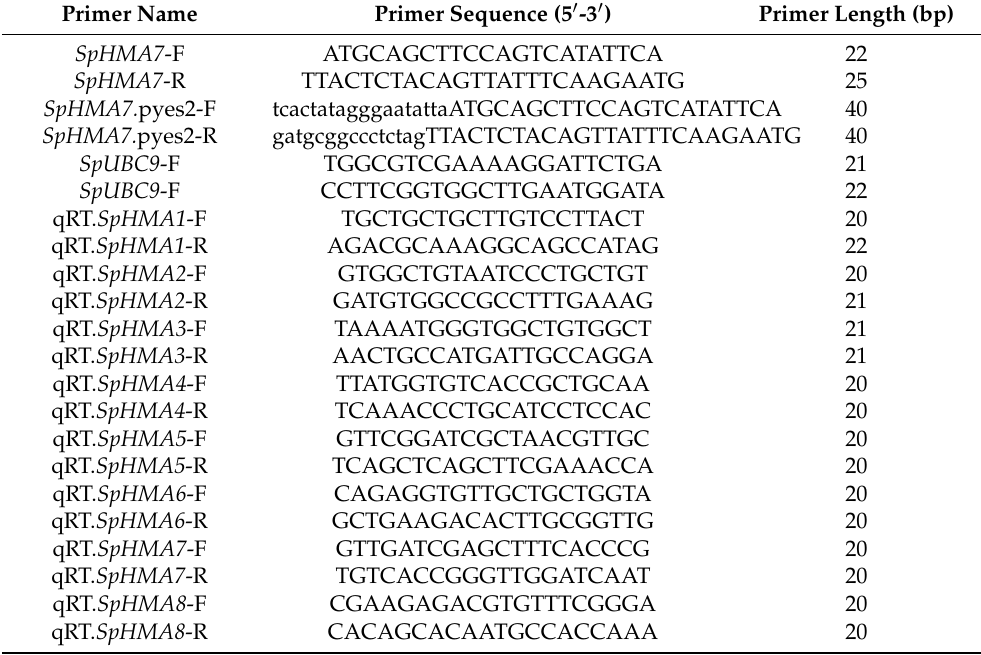
Table 2. Primers used in CDS full-length cloning, yeast heterologous expression vector recombining and